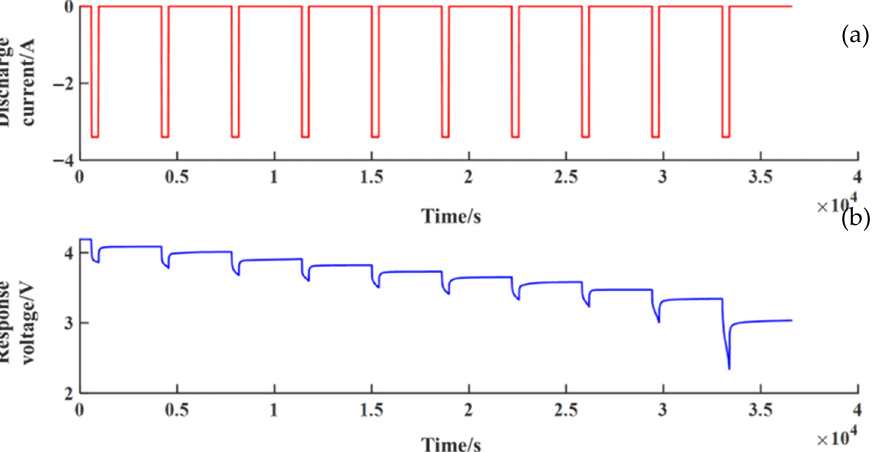
Figure 4. Block diagram of Simulink for the second-order RC equivalent circuit model.